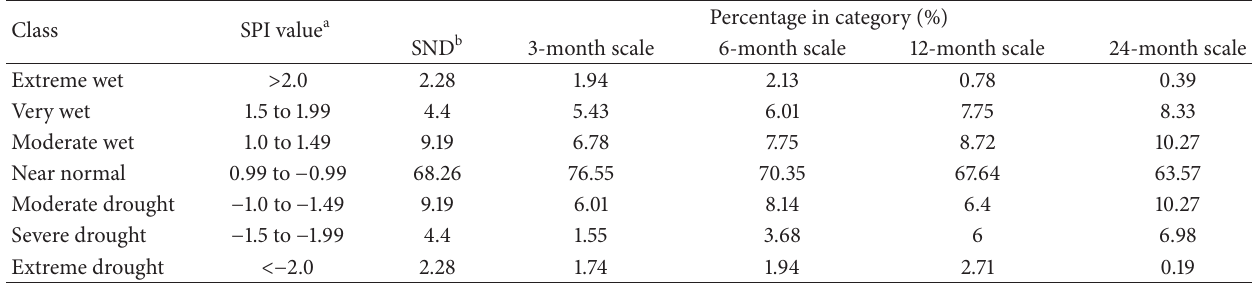
Table 1: SPI values classification and the percentage available in the theoretical standard normal distribution and in the time scales selected for the data of Kuwait.